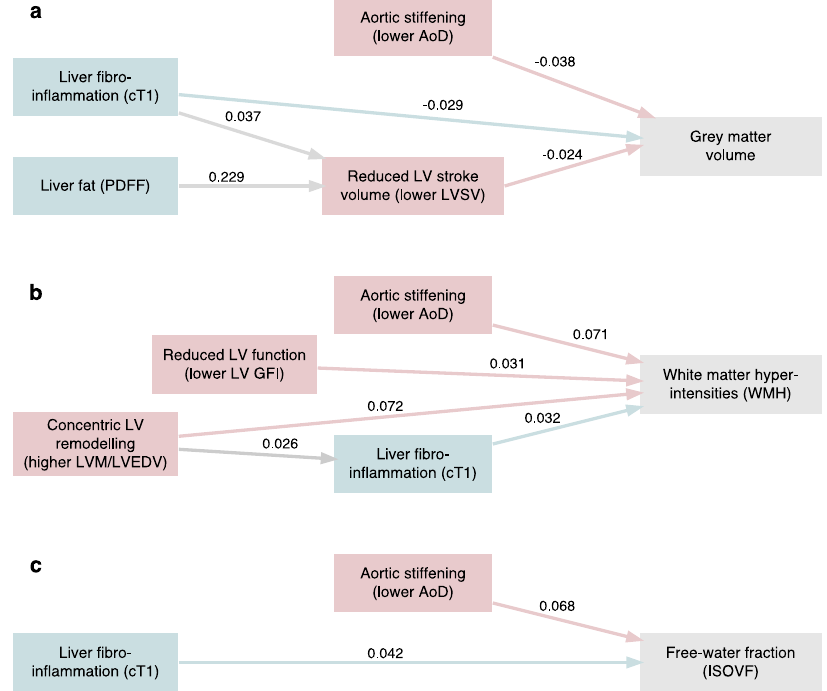
Fig. 4| Simultaneousliver/heart associationswithbrain healthmeasures. Final models and standardised beta coef fi cients from path analyses fi tted using the lavaan package in R. All path analysis models are calculated with 6865 participants. a Simultaneous heart and liver associations with grey matter volume. b Simultaneous heart and liver associations with accumulation of white matter hyperintensities. c Simultaneous heart and liver associations with increased free- water fraction. Brain measures are in grey, heart measures are in pink and liver measuresareinteal.Modelsarebuiltforasinglebrainoutcome,andinitiallyinclude twolivervariablesaspredictors(liverPDFFandcT1)andallheartvariablestogether in two alternative forms (i) Brain ~ Heart + Liver, Heart ~ Liver, and (ii) Brain ~ Heart + Liver, Liver ~ Heart (see Supplementary Fig. 1 for detail). Non-signi fi cant pathswereremovedoneatatimetoreachthe fi nalmodel,thenthebest fi ttingform